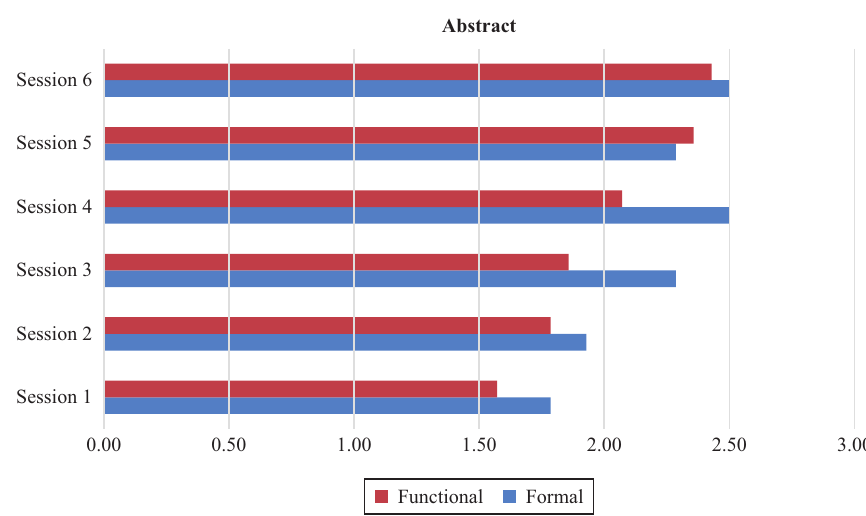
Fig. 3. Transformations occur according to abstract-oriented concepts created during design sessions